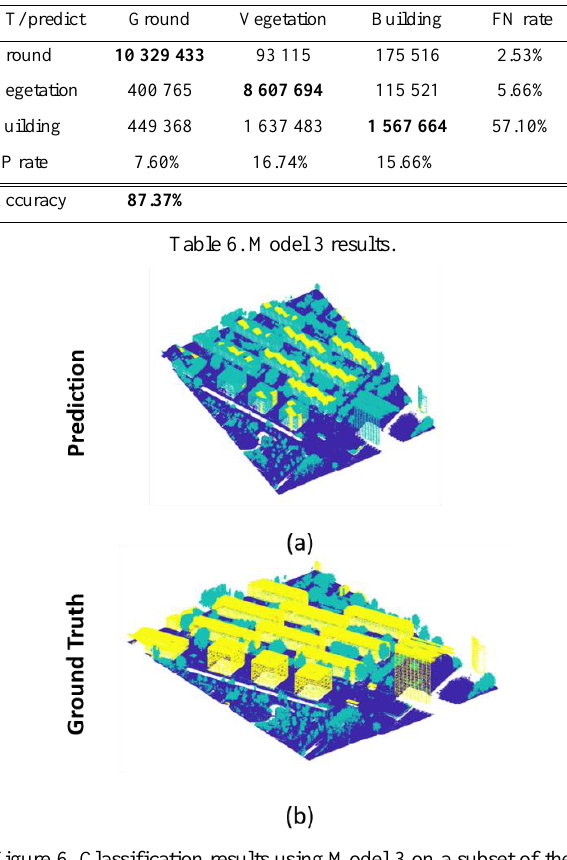
Figure 6. Classification results using Model 3 on a subset of the AHN3 data with a high confusion between vegetation and buildings. (a) Prediction (ground, vegetation and buildings are coloured as blue, green and yellow respectively). (b) Ground truth. Again many